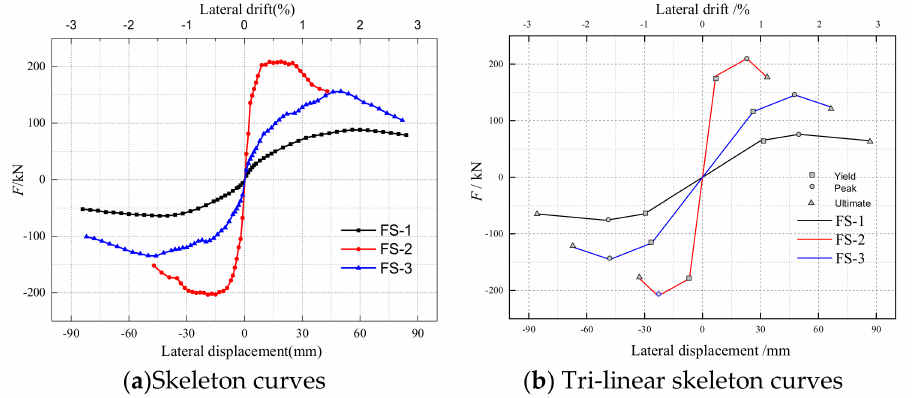
Figure 10. Skeleton curves of all